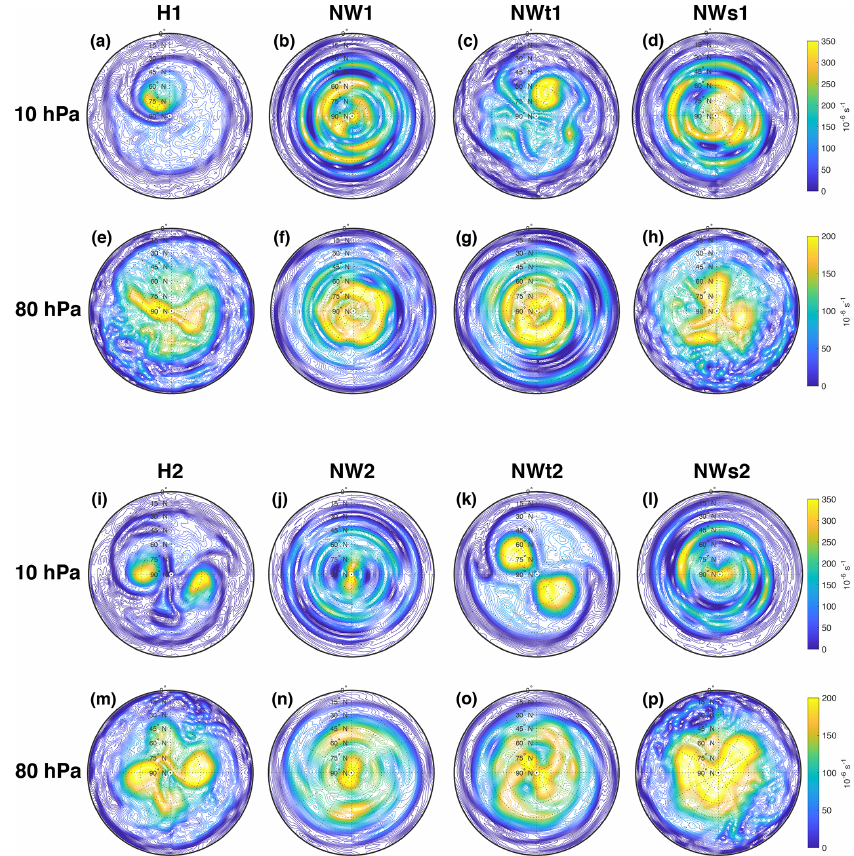
Figure 8. Absolute vorticity at 10 and 80hPa on the central dates of an SSW with wave 1 heating (a–h) and wave 2 heating (i–p) . Displace- ments can be seen in (a) and (c) , while (i) and (k) show